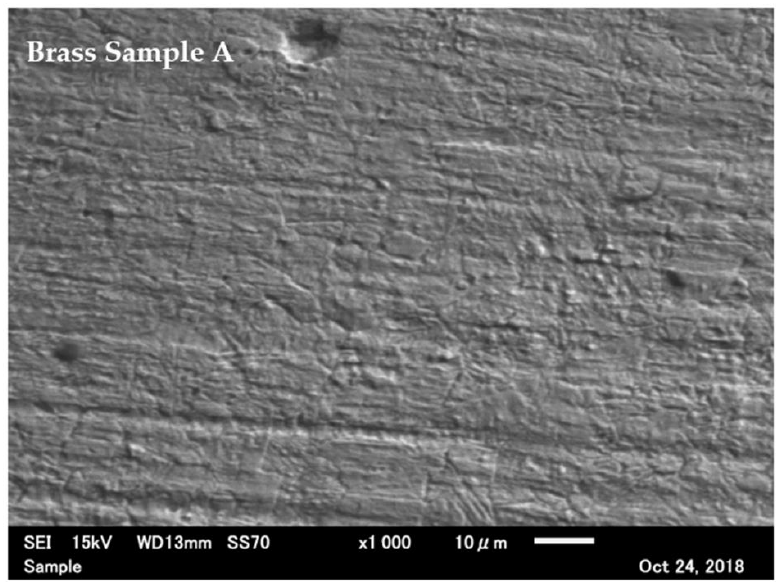
Figure 13. A new brass contact surface before it was subjected to an electrical arc, viewed under an electron microscope at 1000 × magnification.